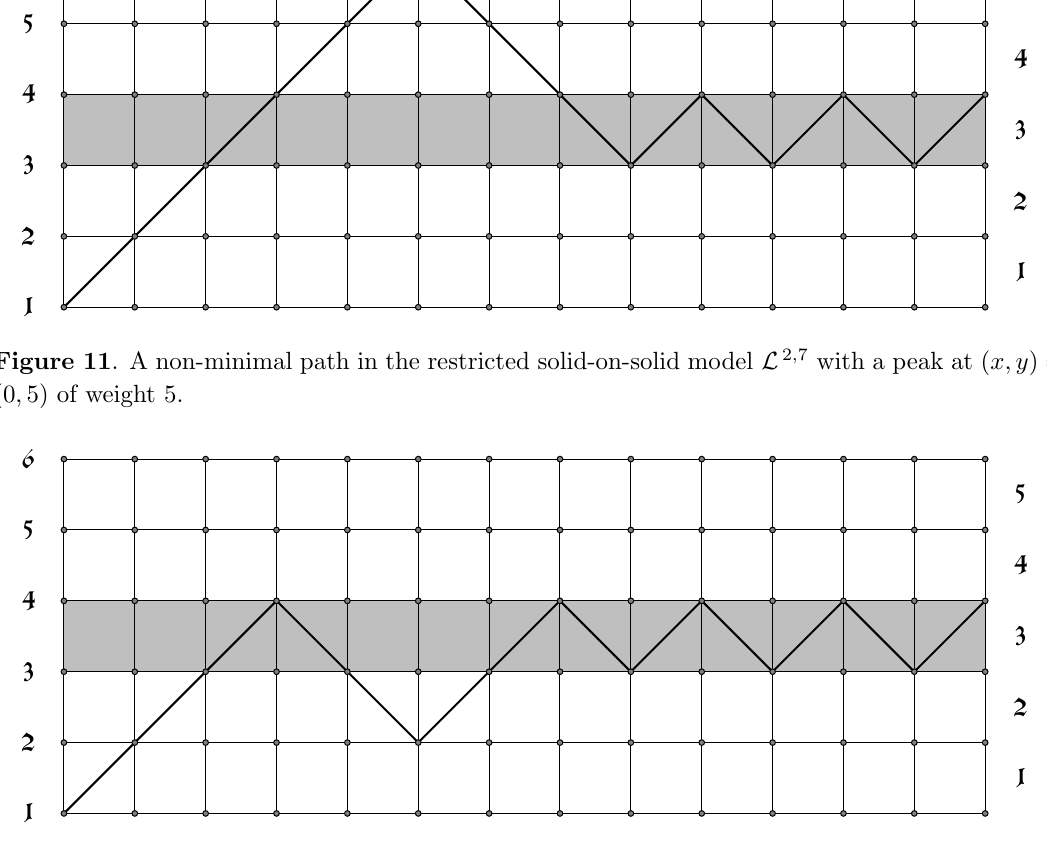
Figure 12 . A non-minimal path in the restricted solid-on-solid model L 2 ; 7 . The valley between the 4-th vertical line (position i = 3) and the 8-th vertical line (position i = 7) is obtained